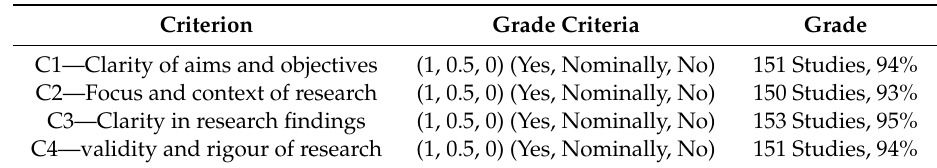
Figure 1. The research approach for exclusion and Inclusion—Adapted from Xiao and Watson [36]. Table 1. Assessment of